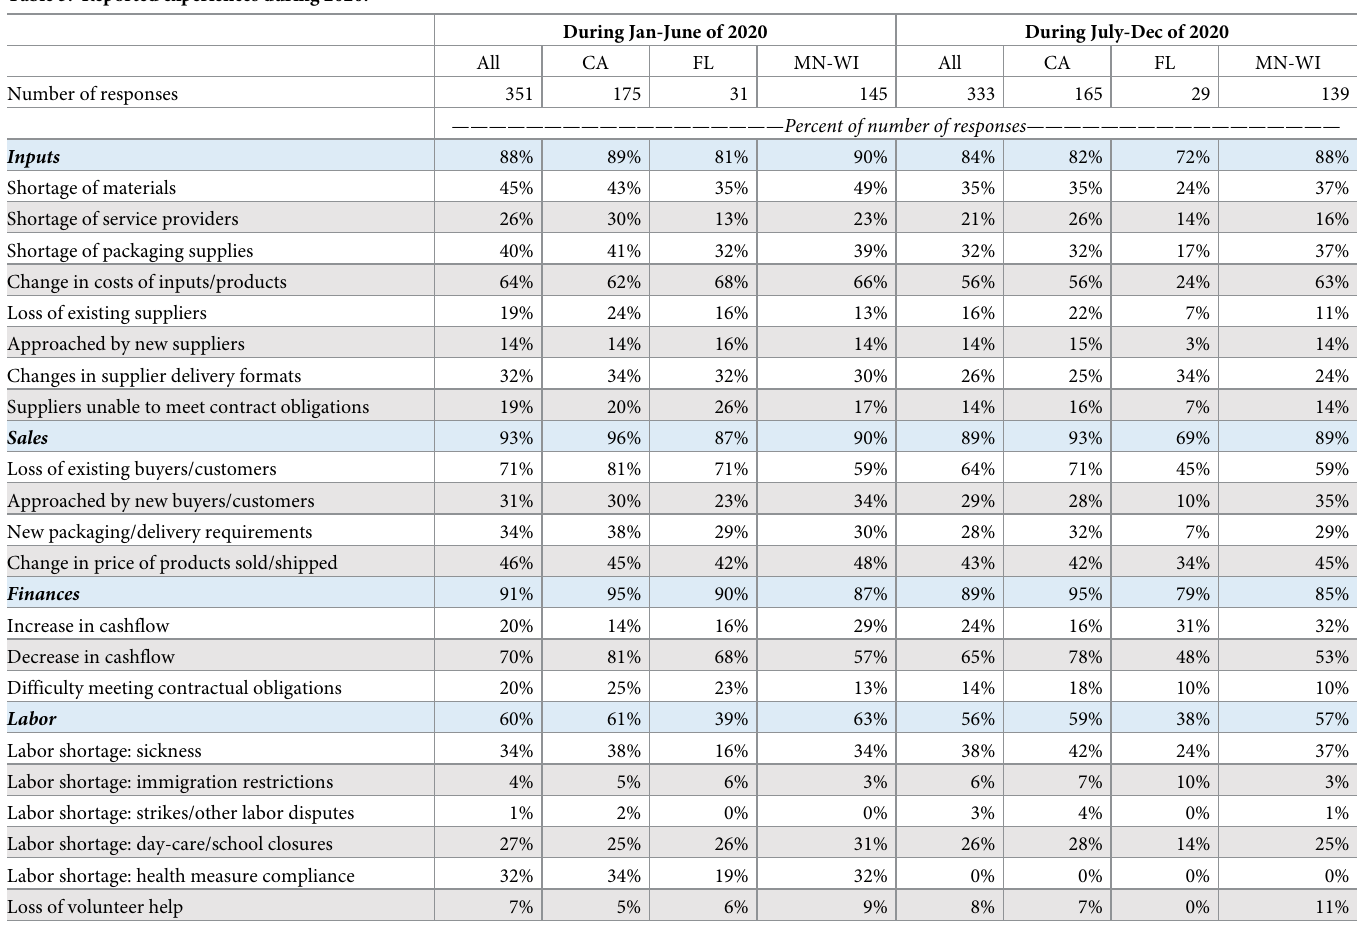
Table 3. Reported experiences during